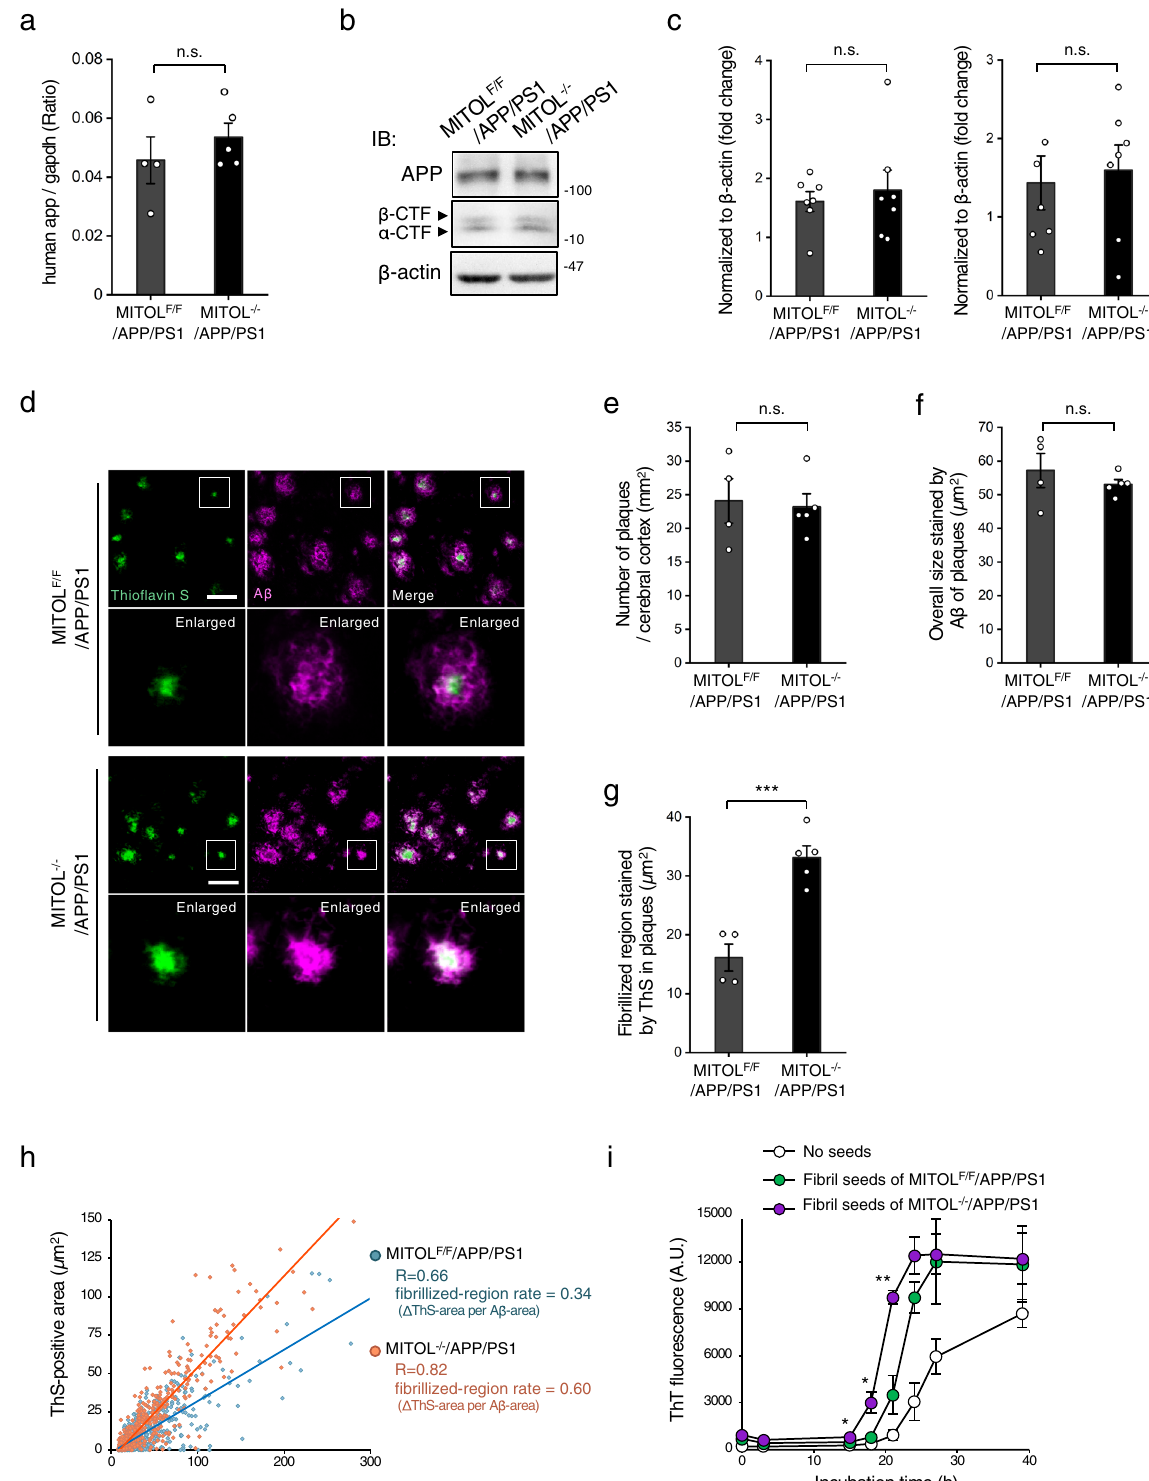
and behavioral symptoms in an oligomeric A β -dependent manner (Supplementary Fig. 5e).